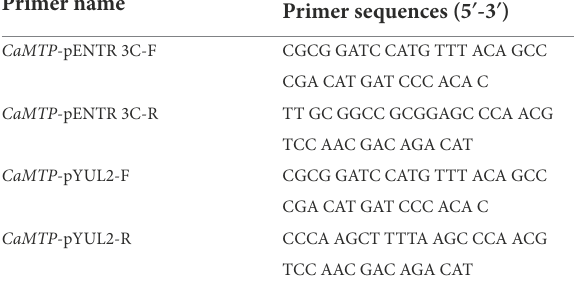
TABLE 1 Sequence of primers used to insert CaMTP into the pENTR 3C and pYUL2